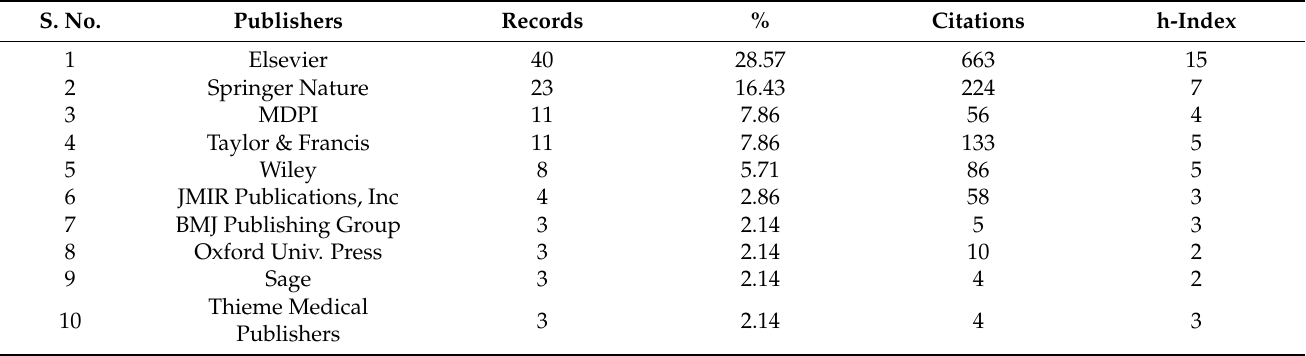
Table 4. Distributions of publishers in health science